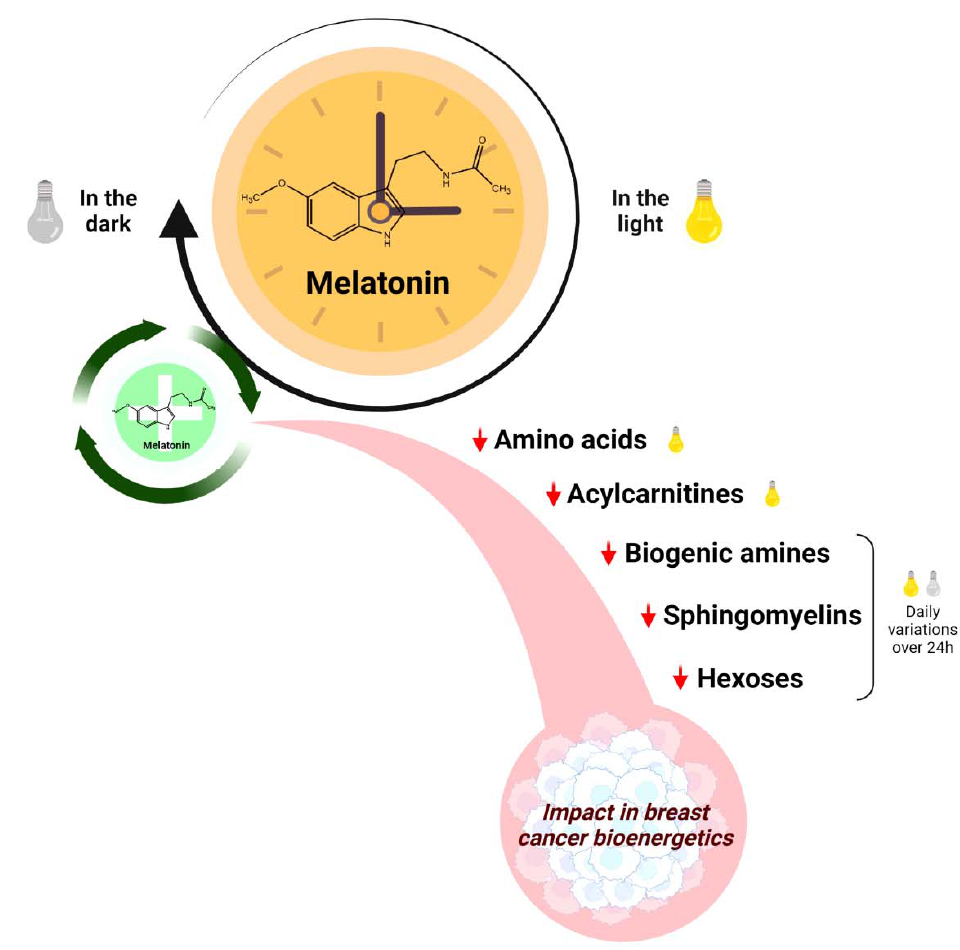
Figure 9. Melatonin has a controlled biosynthesis by the circadian clock (black circular arrow), with a significant decline in the light phase of the day (yellow lamp). A prolonged cycle of melatonin treatment in the early dark phase (green circular arrow) reduces the plasma concentrations of specific amino acids, acylcarnitines, biogenic amines, sphingomyelins, and hexoses mainly in the light phase of the day, which may impact breast cancer bioenergetics. Red arrows = reduced levels.